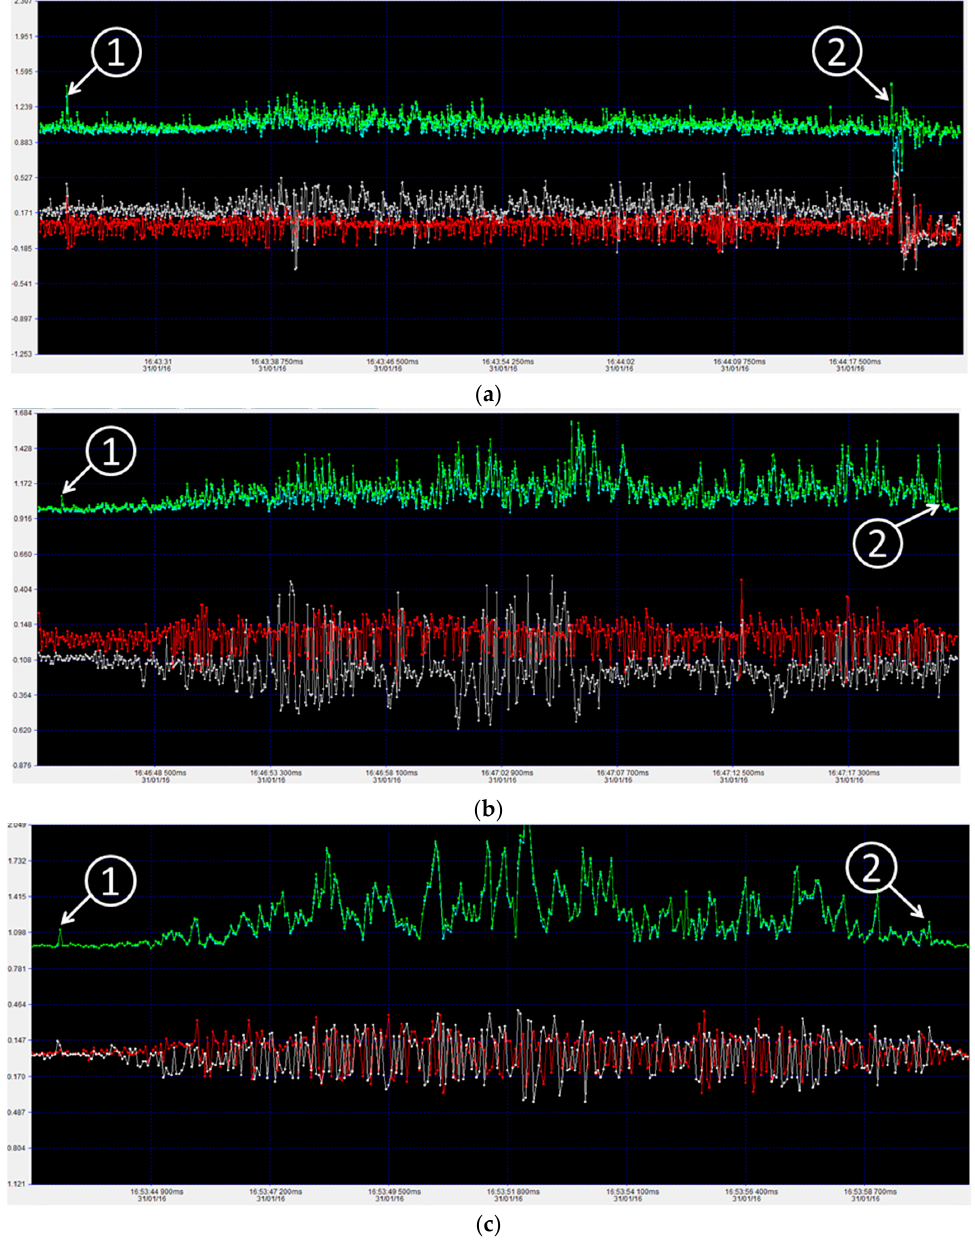
Figure 11. Platform vibration at different moving speed. ( a ) Platform vibration moving at 0.05 m/s; ( b ) Platform vibration moving at 0.10 m/s; ( c ) Platform vibration moving at 0.15 m/s.